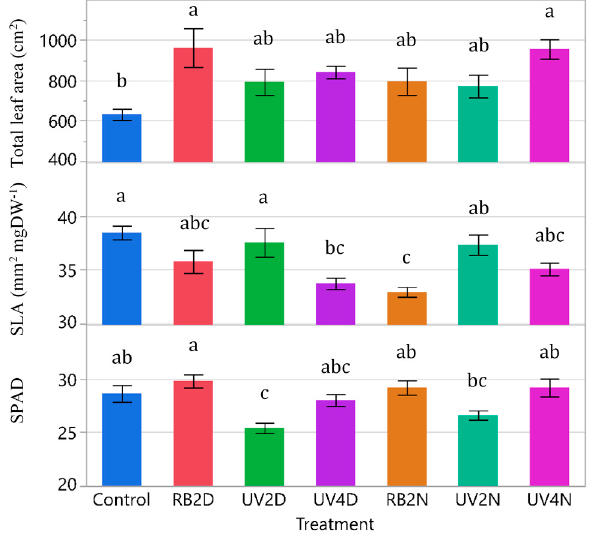
Figure 3. Total leaf area, specific leaf area (SLA), and relative chlorophyll content (SPAD), of the lettuce variety ‘Red Mist’ treated with pre-harvest supplemental UV-A/Blue (UV) or Red and Blue (RB) LED light for a duration of either two or four days (D) or nights (N), in a greenhouse hydroponic system (Experiment 1). The control plants did not receive any supplemental LED light. See Table 2 for treatment details. Means separated by different letters indicate significant differences according to Tukey’s HSD (honestly significant difference) test ( p < 0.05). Bars represent standard error.